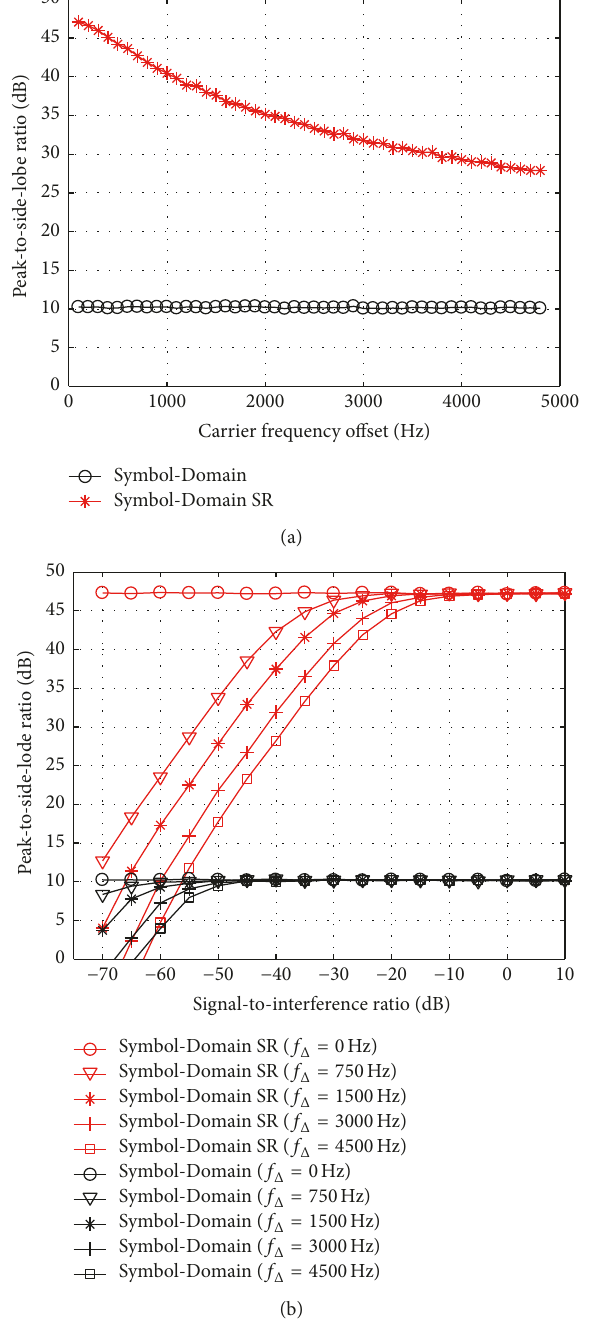
Figure 9: Peak-to-side-lobe ratio with multiuser interference when carrier frequency offset exists. (a) PSLR versus different frequency offset when SIR = − 40dB. (b) PSLR versus different SIRs.